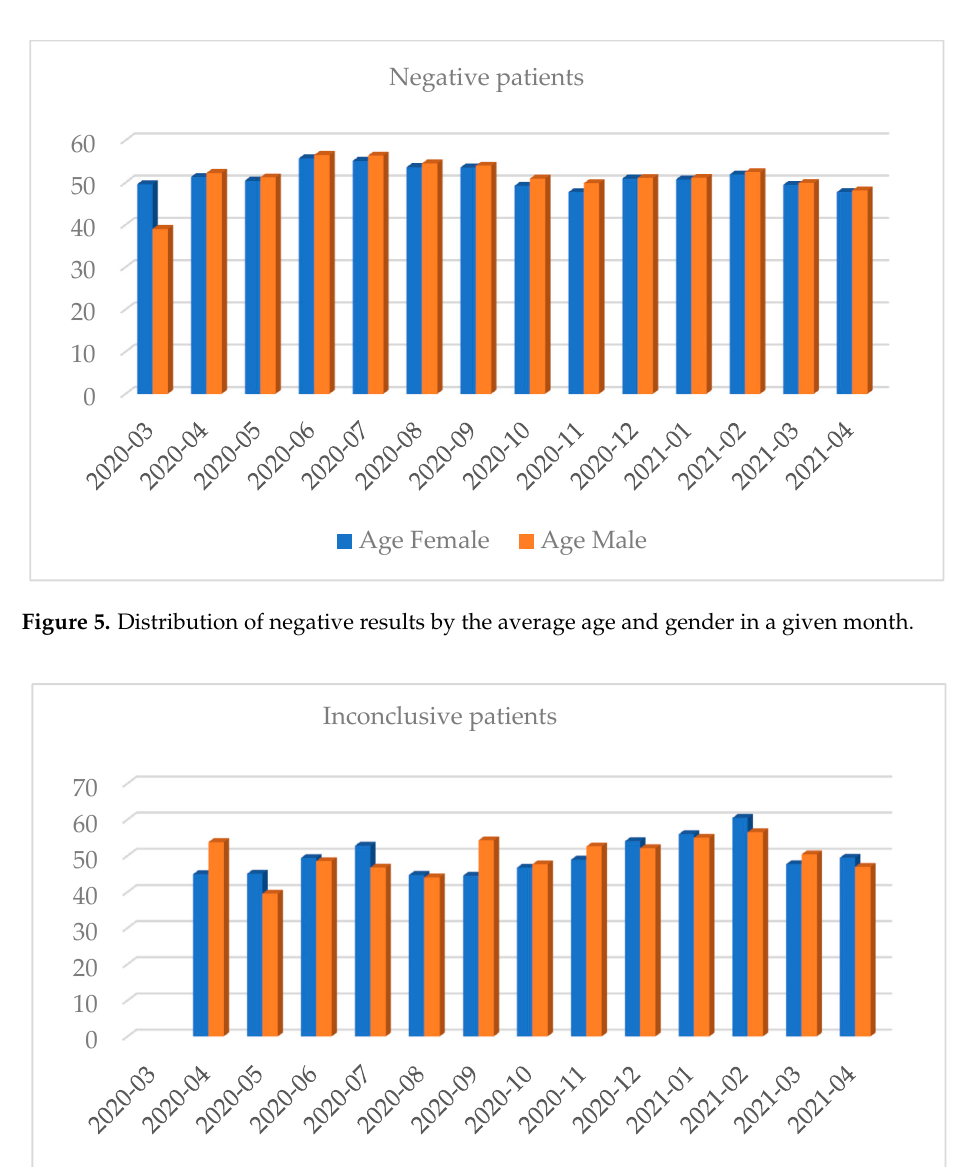
Figure 6. Distribution of inconclusive results by the average age and gender in a given month.